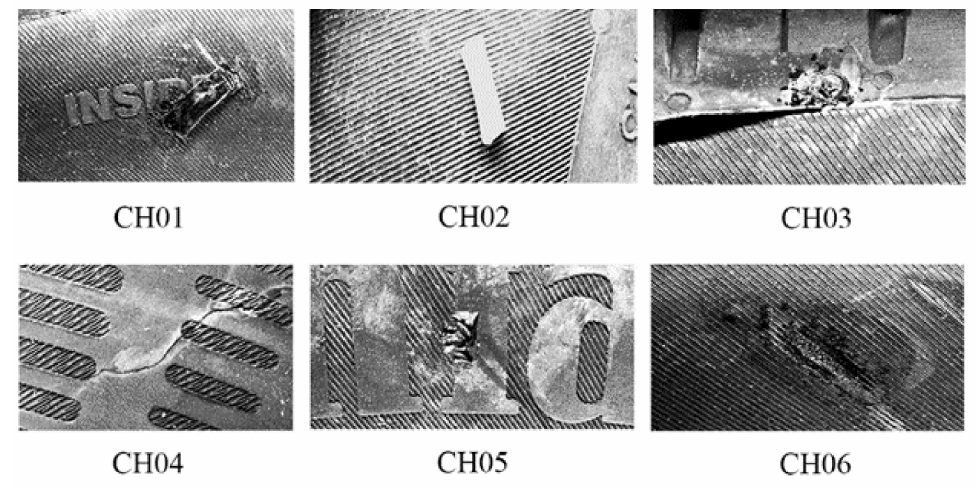
Figure 2. Testing elements (defects) [9,26].